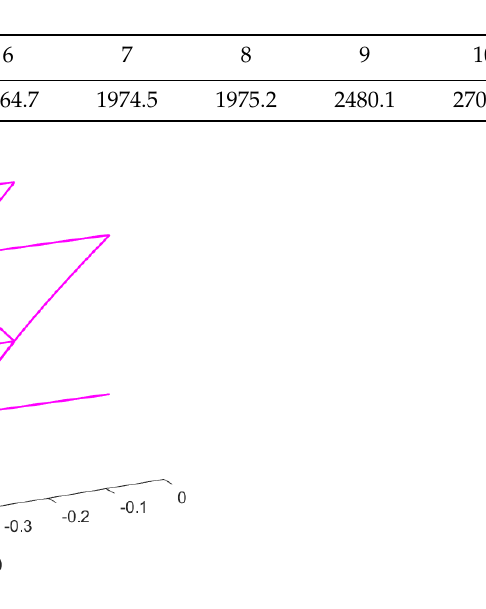
Table 9. Natural Frequencies, ω ( rad / s ) of Timoshenko beam Analysis with Hinged ends in Topology 2, original configuration.